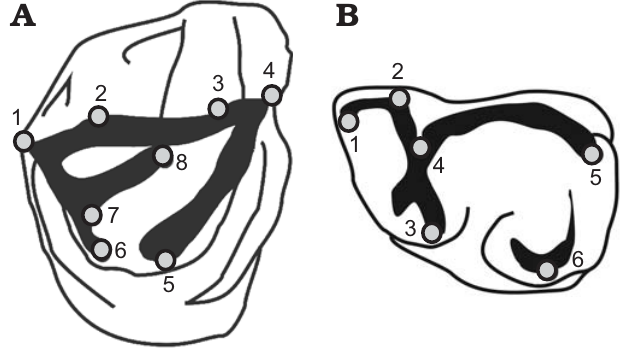
Fig. 1. Landmark configurations maped onto a hypothetical generalized henricosborniid. A . Upper molar: 1, metastyle; 2, metacone; 3, paracone; 4, parastyle; 5, protocone; 6, hypocone; 7, distolingual end of crochet; 8, mesio labial end of crochet. B . Lower molar: 1, labial end of paralo- phid; 2, labial end of metalophid; 3, lingual end of metalophid; 4, mesial end of cristid obliqua; 5, hypoconulid; 6, entoconid/lingual end of en- tolophid.